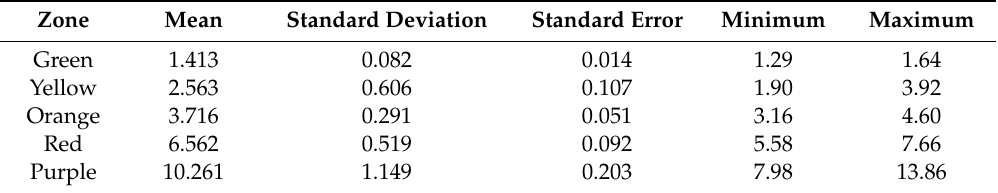
Table 5. Calculated OCRA